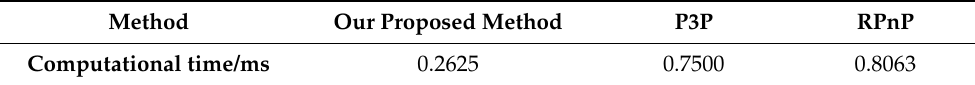
Table 1. Computational